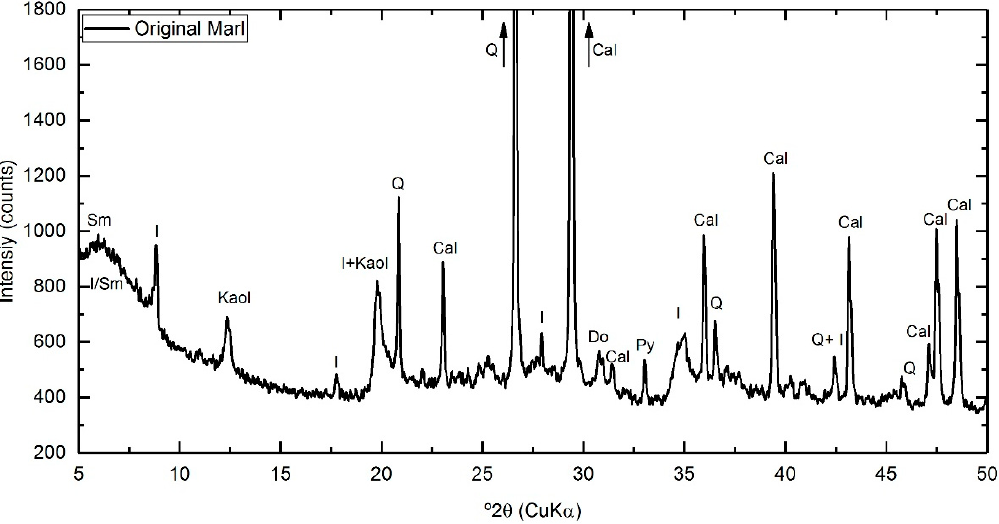
Figure 1. XRD-pattern of the raw blue marl. Cal: calcite; Q: quartz; Do: dolomite; I: illite; Kaol: kaolinite; Sm: smectite; I/Sm: mixed-layer illite-smectite. Table 1. Mineralogical semi-quantification composition (wt%) of the original and treated samples after the reaction period of 120 and 240 h. σ : 3 x Estimated standard deviation = 99.7% repeatability